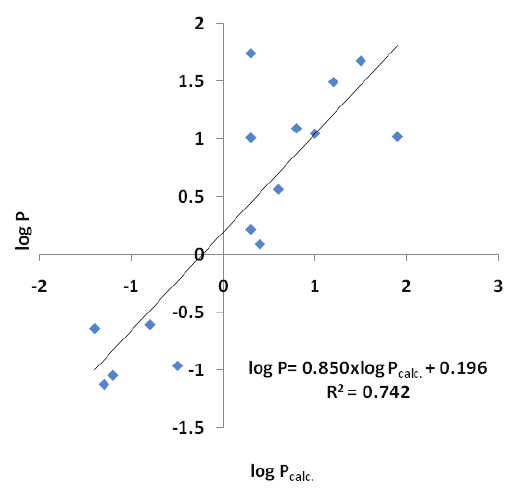
Figure 7. Plot of log P vs. log P calc. for the test set (external validation).